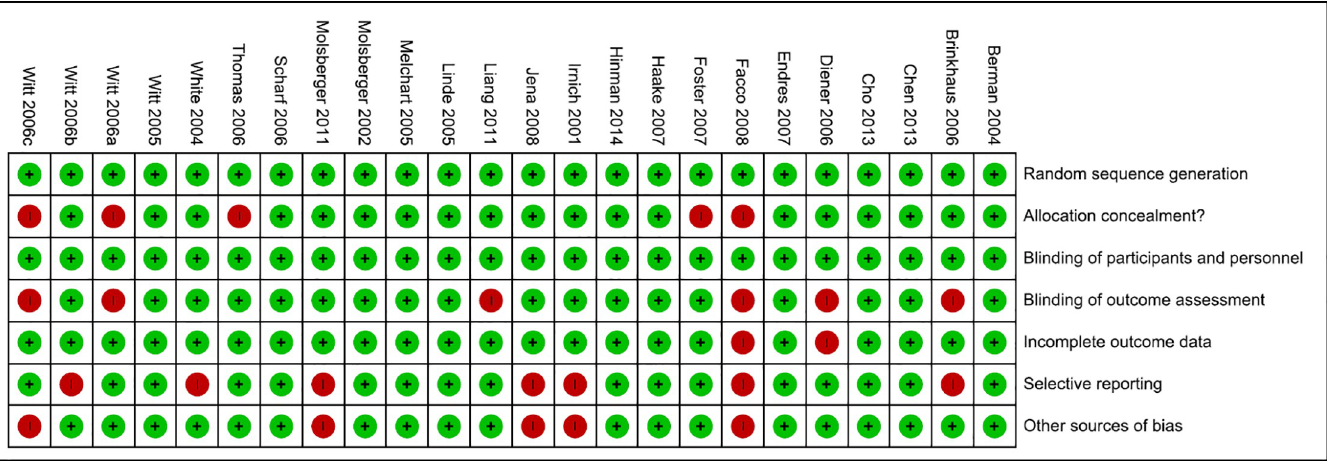
Fig 2. Summary of bias risk of individual studies.